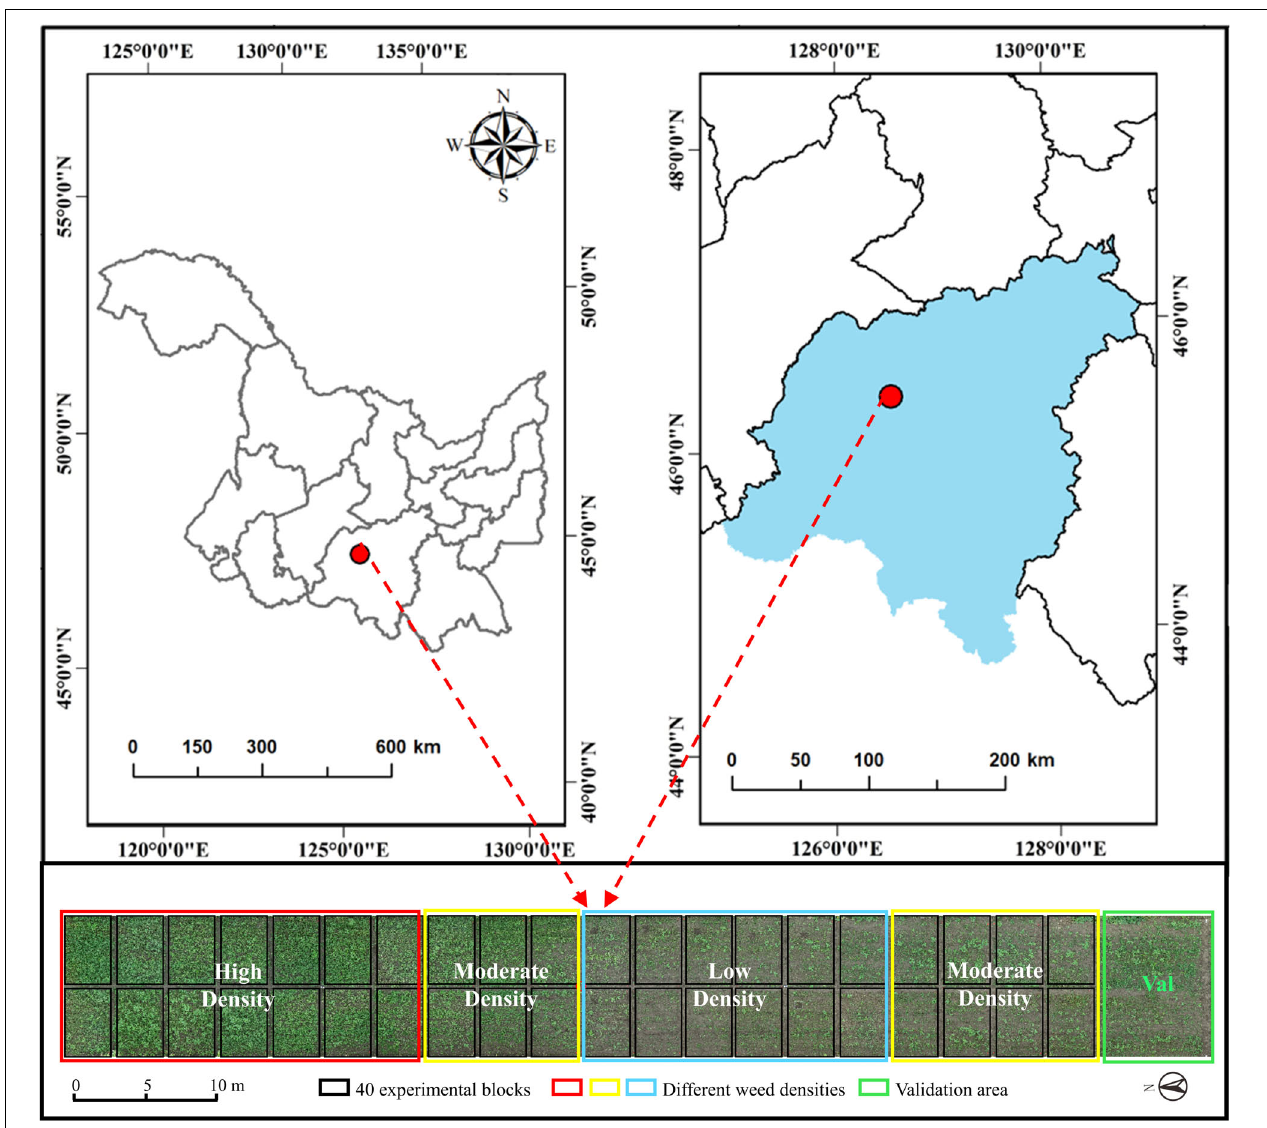
FIGURE 1 | Distribution of test sites and test